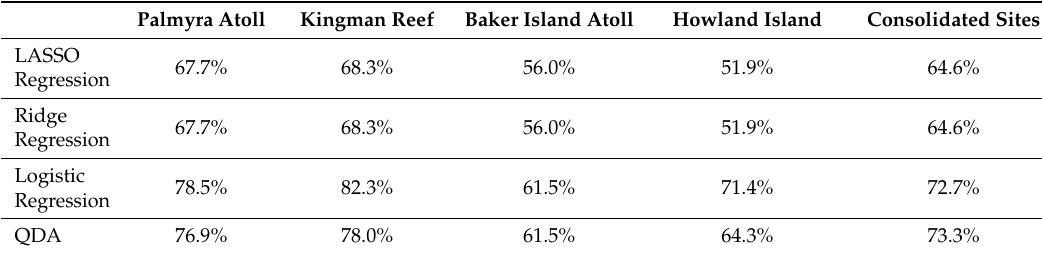
Table 7. Classification accuracy of select additional learning